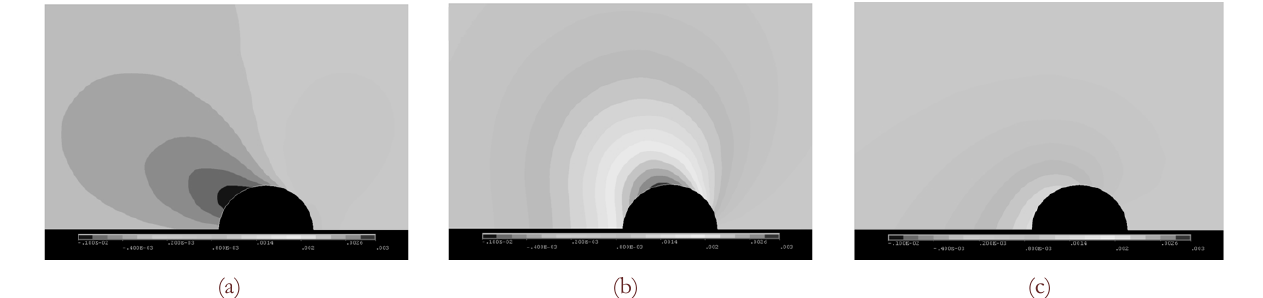
Figure 2: The displacement field u, v, w (a, b, c, respectively) due to the to the formation of the hole in the vicinity of the surface crack